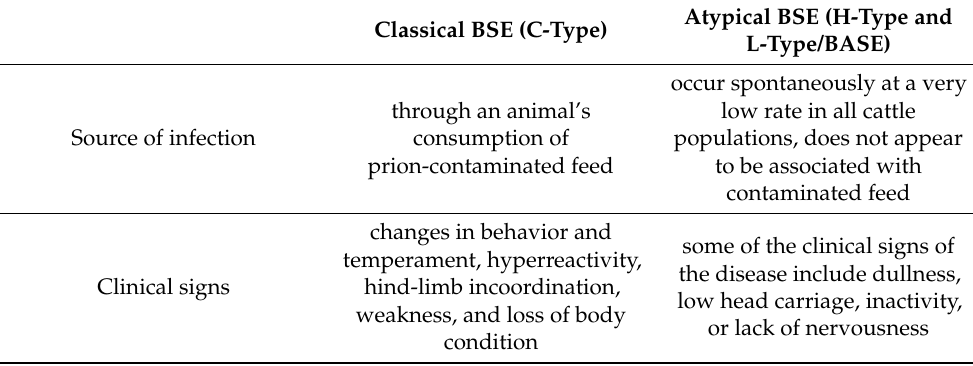
Table 1. The main characteristic features of BSE